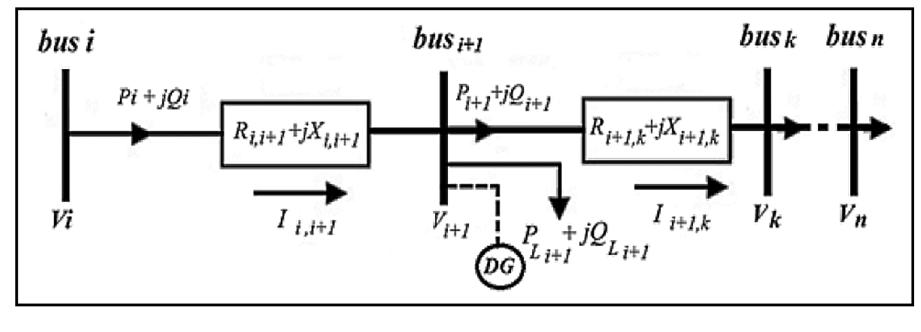
Figure 2: A line radial feeder diagram with DG